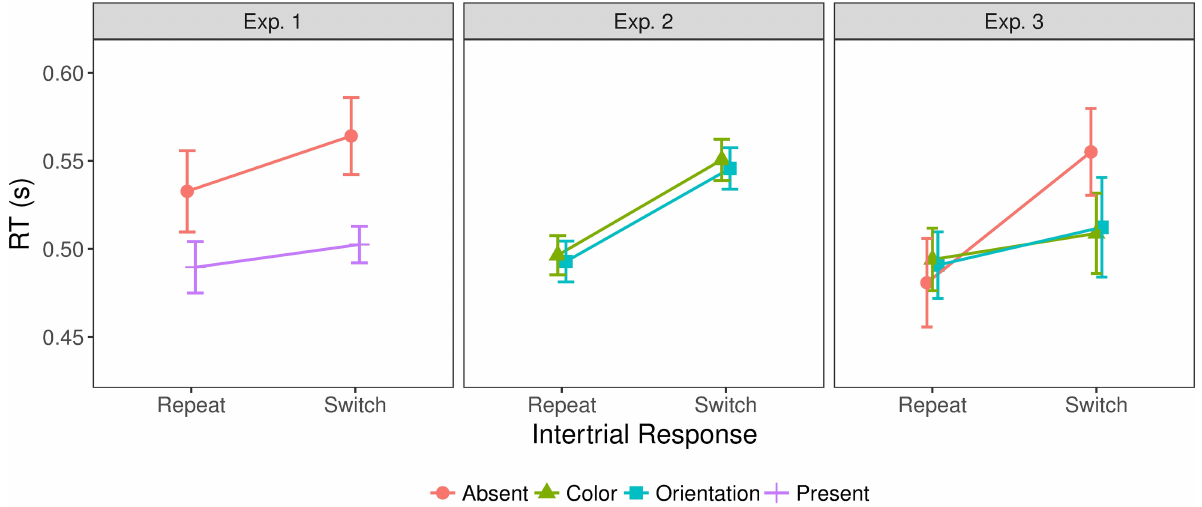
Fig 4. Inter-trial effects on mean RTs for all three experiments. Error bars show the standard error of the mean.